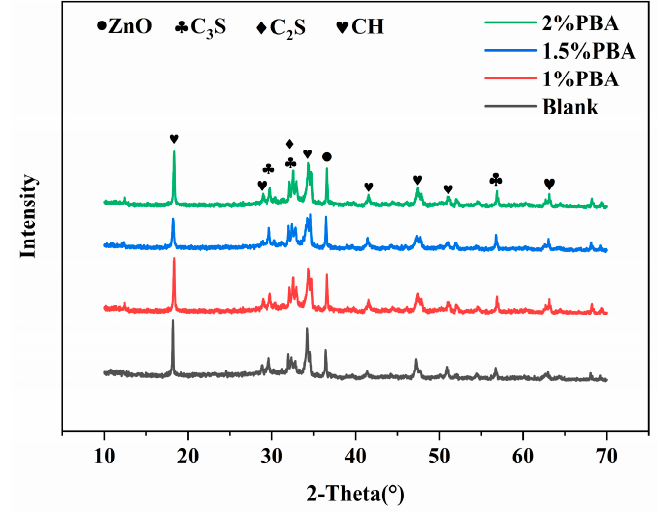
Figure 6. The effect of PBA on the early phase composition of cement hydration. Figure 6. The e ff ect of PBA on the early phase composition of cement hydration. Table 5. Composition (wt%) of cement hydration slurry by Rietveld refinement. Table 5. Composition (wt%) of cement hydration slurry by Rietveld re fi nement. Sample